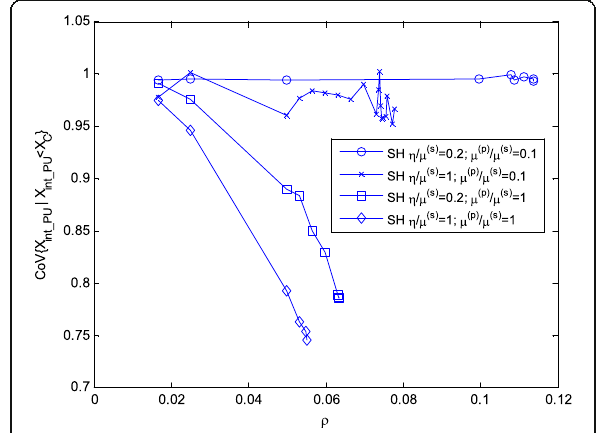
Fig. 12 Coefficient of variation of the conditional call interruption time given that calls are interrupted by the arrival of PUs for different values of the primary channel utilization factor ( ρ